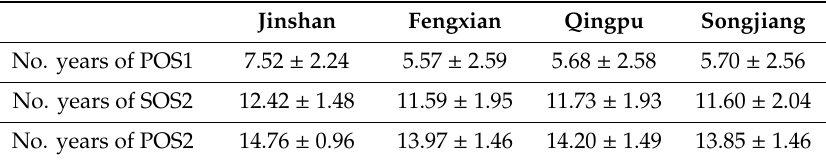
Table 2. Mean and standard deviations of the number of years that LDCP were able to derive POS1, SOS2, and POS2 in the four counties,